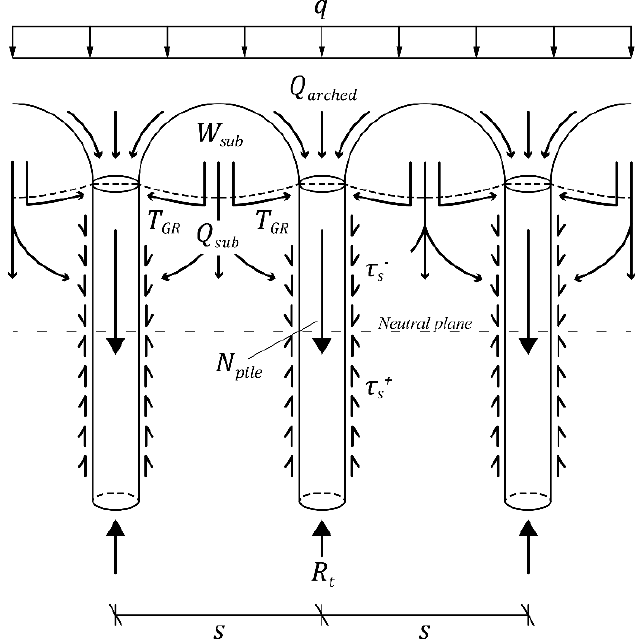
Figure 2. Illustration of the load distribution in a geosynthetic-reinforced pile-supported embankment (GRPSE).